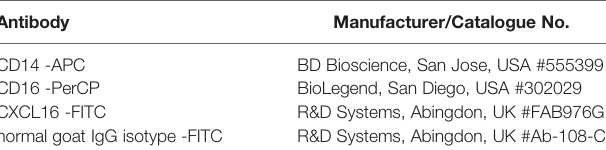
TABLE 2 | Antibodies used for fl ow cytometry immuno fl uorescence for PBMC